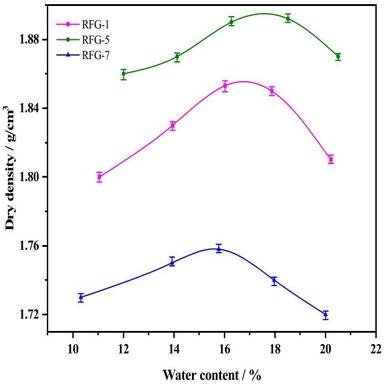
Compaction test results.